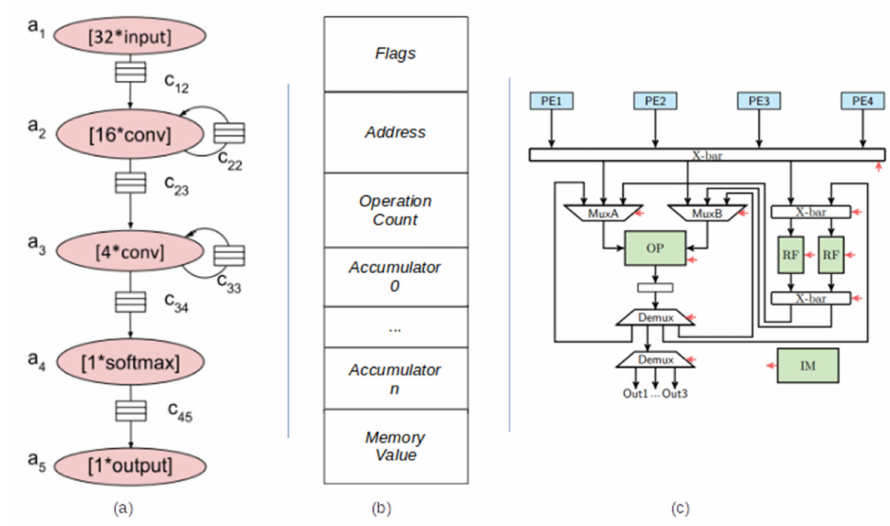
Figure 4. Memory constraints and optimization methods, ( a ) Cyclo-Static datafle model for inter- mediate data storage in reduced memory size, ( b ) transactions in read-modify-write operations for